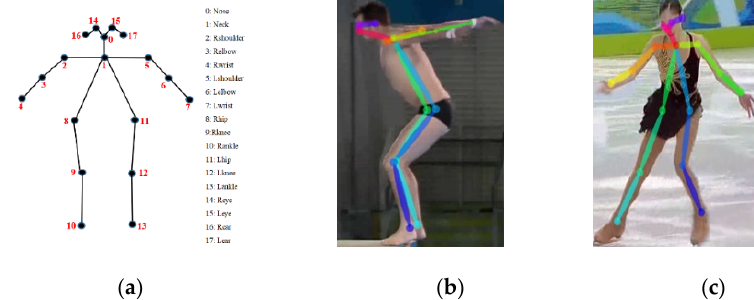
Figure 4. Skeleton model and detection examples of OpenPose [60]. ( a ) Eighteen-joint skeleton model of OpenPose; ( b ) example of diving; ( c ) example of figure skating.